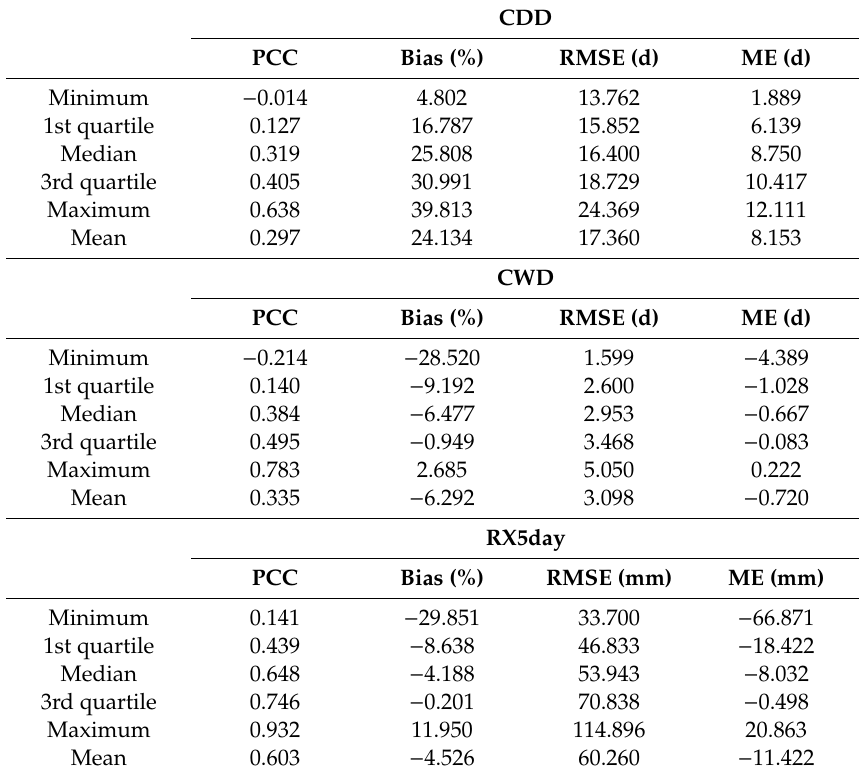
Table 2. Results of three consecutive extreme climate event indices from 1998 to